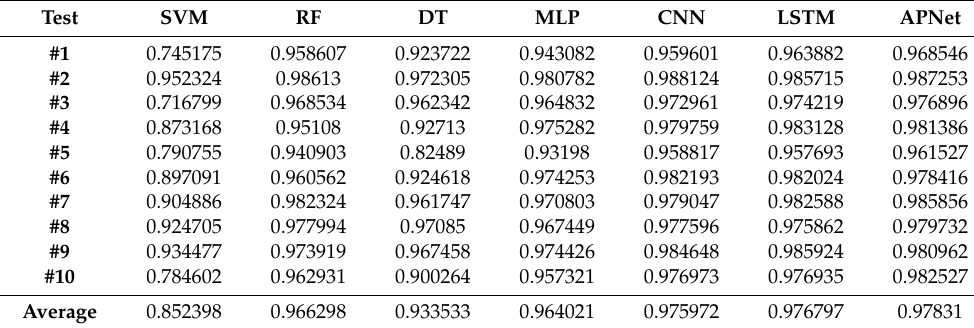
Table 4. The Index of Agreement